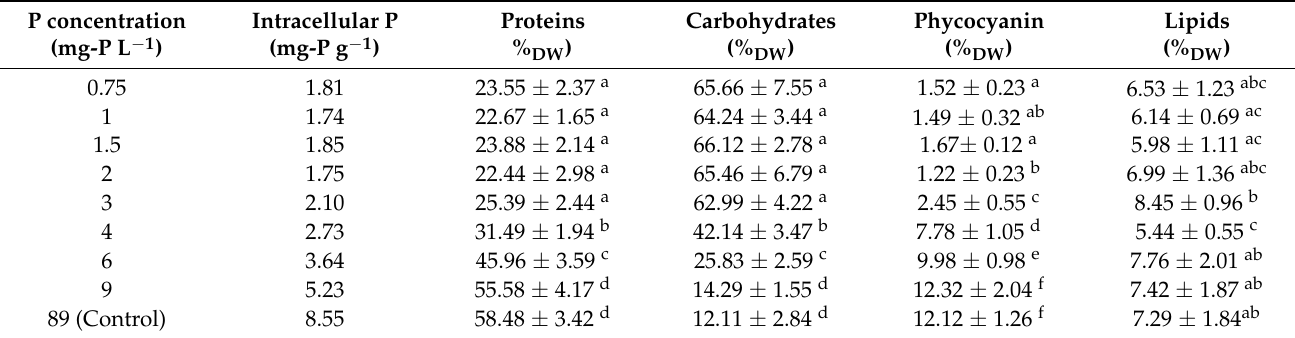
Figure 1. ( a ) Relationship between phosphorus concentration with biomass production and intracellular phosphorus content of A. platensis cultivated in semi-continuous mode with diverse phosphorus limitation degrees. ( b ) Relationship between intracellular phosphorus content and single-cell alkaline phosphatase activity of A. platensis. Table 1. Biochemical composition of A. platensis cultivated in semi-continuous mode with different phosphorus concentra- tions. Data shown are the mean ± SD of n =